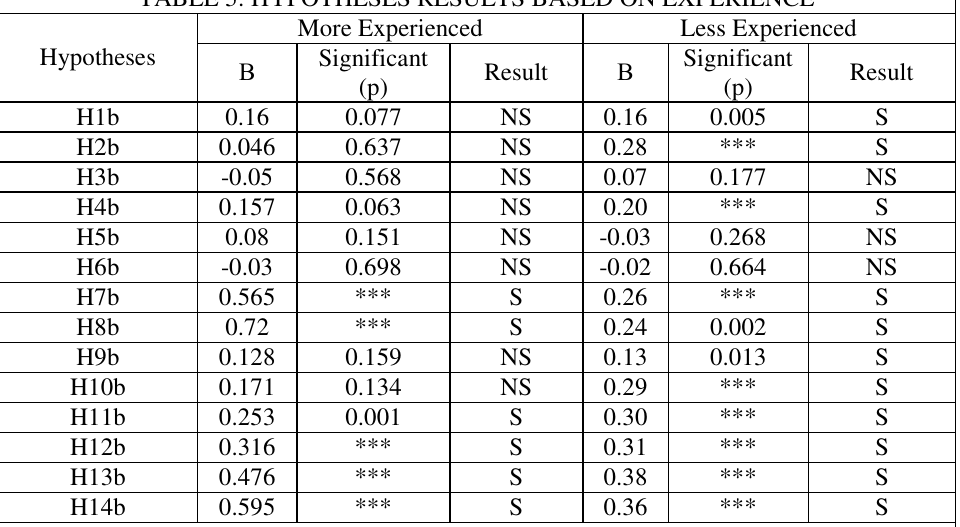
TABLE 5: HYPOTHESES RESULTS BASED ON EXPERIENCE